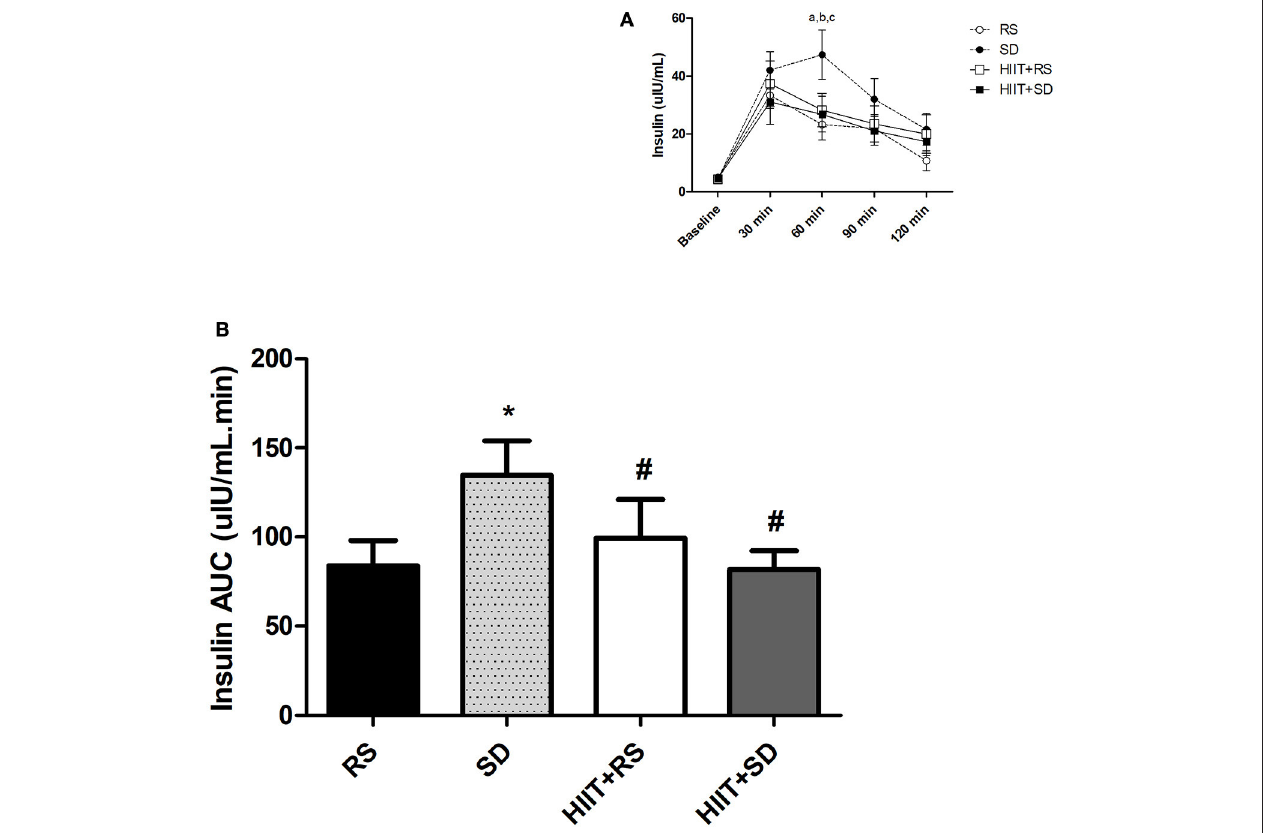
FIGURE 3 | Insulin curve and area under the curve of insulin. (A) Insulin curve during OGTT and (B) AUC of Insulin after OGTT. GLM for repeated measures with Post-Hoc Newman Keuls Test. Data presented as mean ± SEM. *Different to RS condition; # Different to SD condition; a SD condition different to RS condition; b HIIT + SD condition different to SD condition; c HIIT + RS condition different to SD condition. Min, minutes; AUC, Area Under the Curve; OGTT, Oral Glucose Tolerance Test.